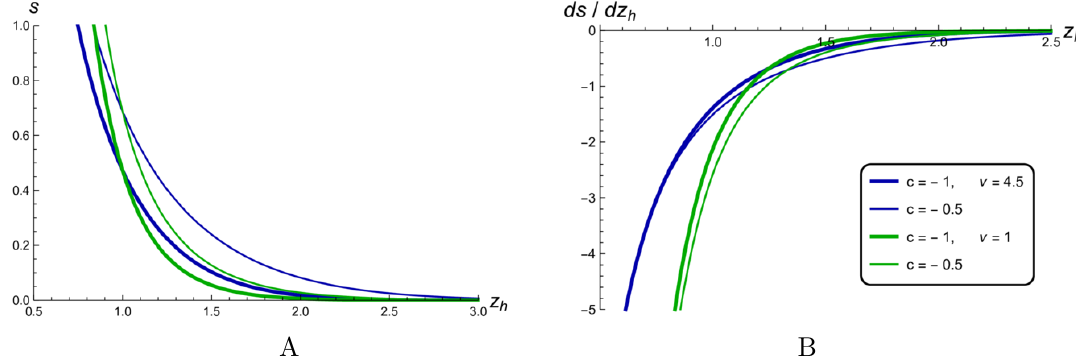
Figure 22 . The black hole entropy s ( z h ) for (cid:22) = 0 and di(cid:11)erent c in isotropic (green lines) and anisotropic (blue lines) (A) cases; the velocity of the entropy decreasing @s ( z h ) =@z h (B); the plot legends are the same for both